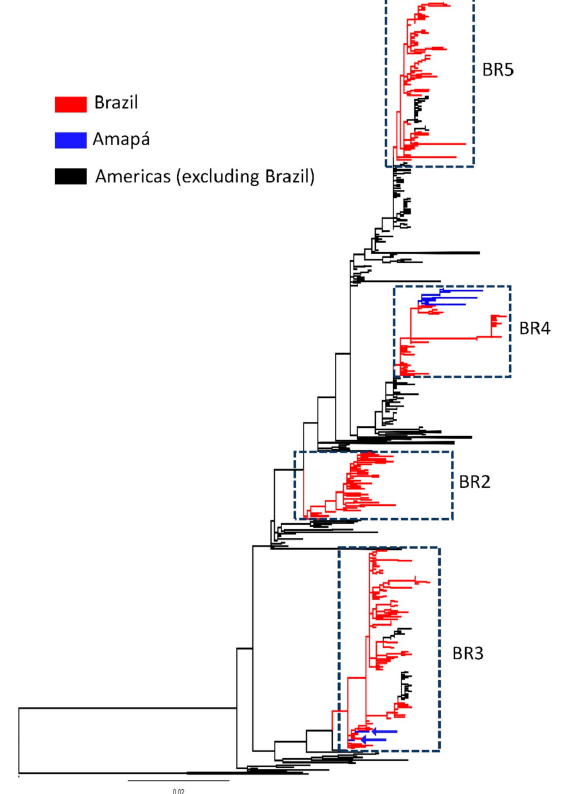
Figure 1. Phylogenetic tree from all DENV-1 genotype V envelope sequences deposited in GenBank database ( n = 1255 sequences, l = 1485 nucleotides). The tree was constructed using the Maximum Likelihood approach and envelope sequences of DENV-1. Colors represent different sample locations. Amap á sequences are highlighted in blue, and the arrows signal the Amap á sequences obtained in mid-2000. The Brazilian lineages (BR2–BR5) are indicated by hatched rectangles. The tree was constructed using the software